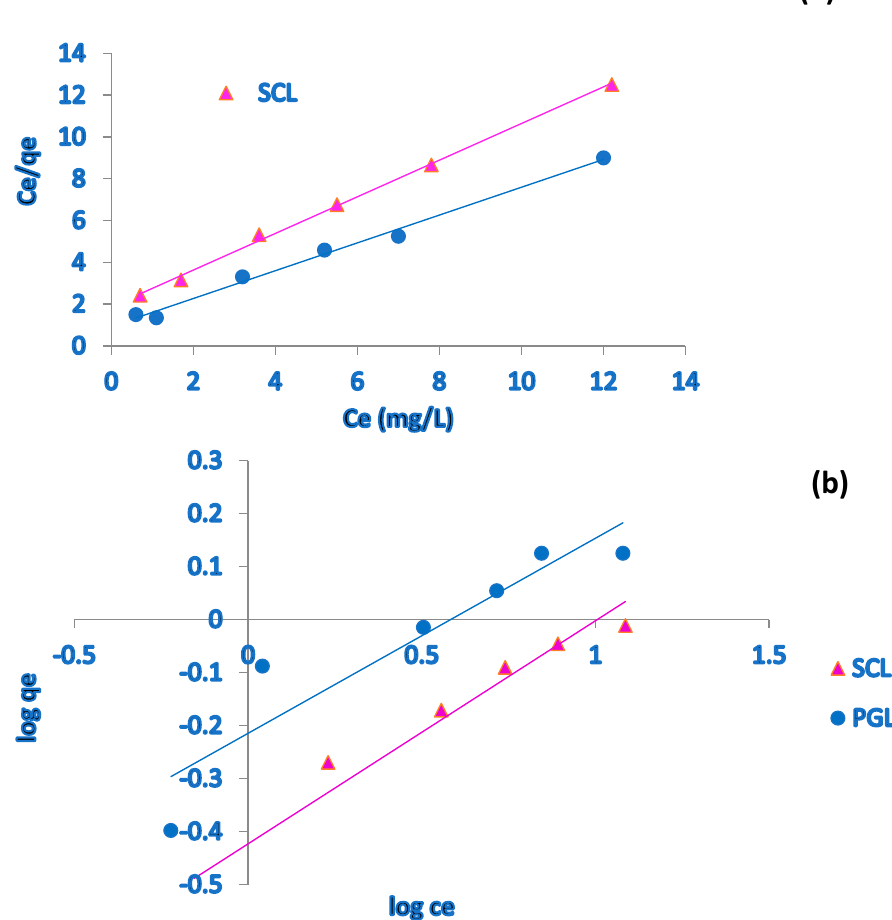
Figure 9. Adsorption values fitted with ( a ) Langmuir and ( b ) Freundlich isotherms. Conditions: pH = 5; adsorbent dosage = 8 g/L; t = 80 for SC and pH = 5.1, adsorbent dosage = 6 g/L, t = 90 min for PG.